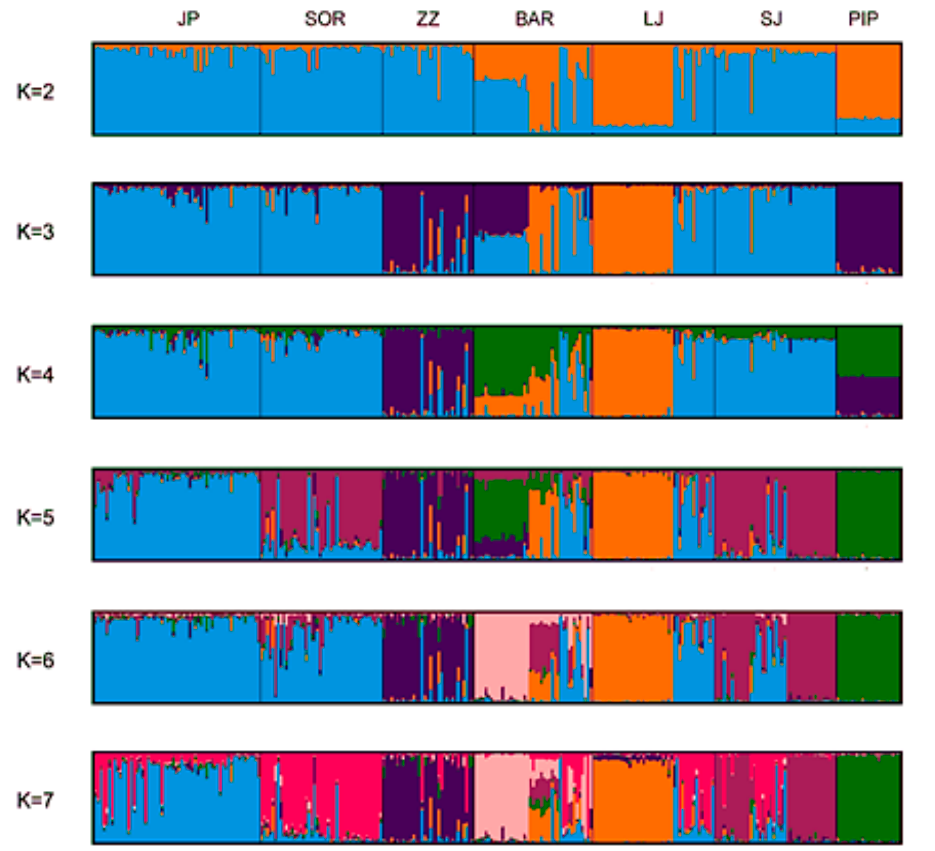
Figure 3. Clustering of sheep breeds by STRUCTURE.